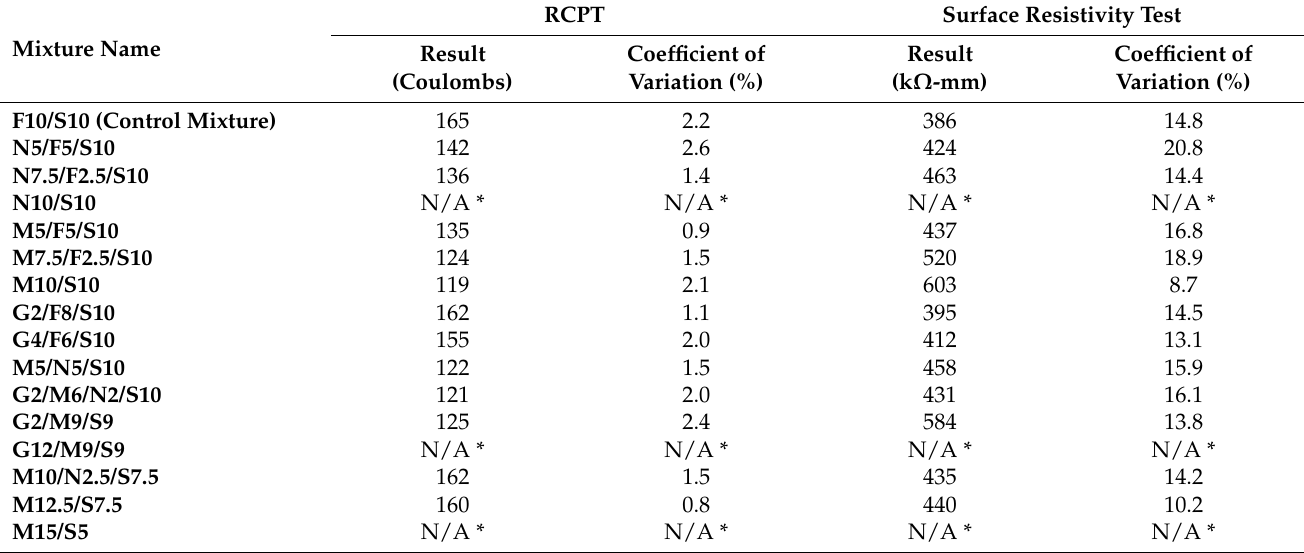
Table 5. RCPT and surface resistivity test